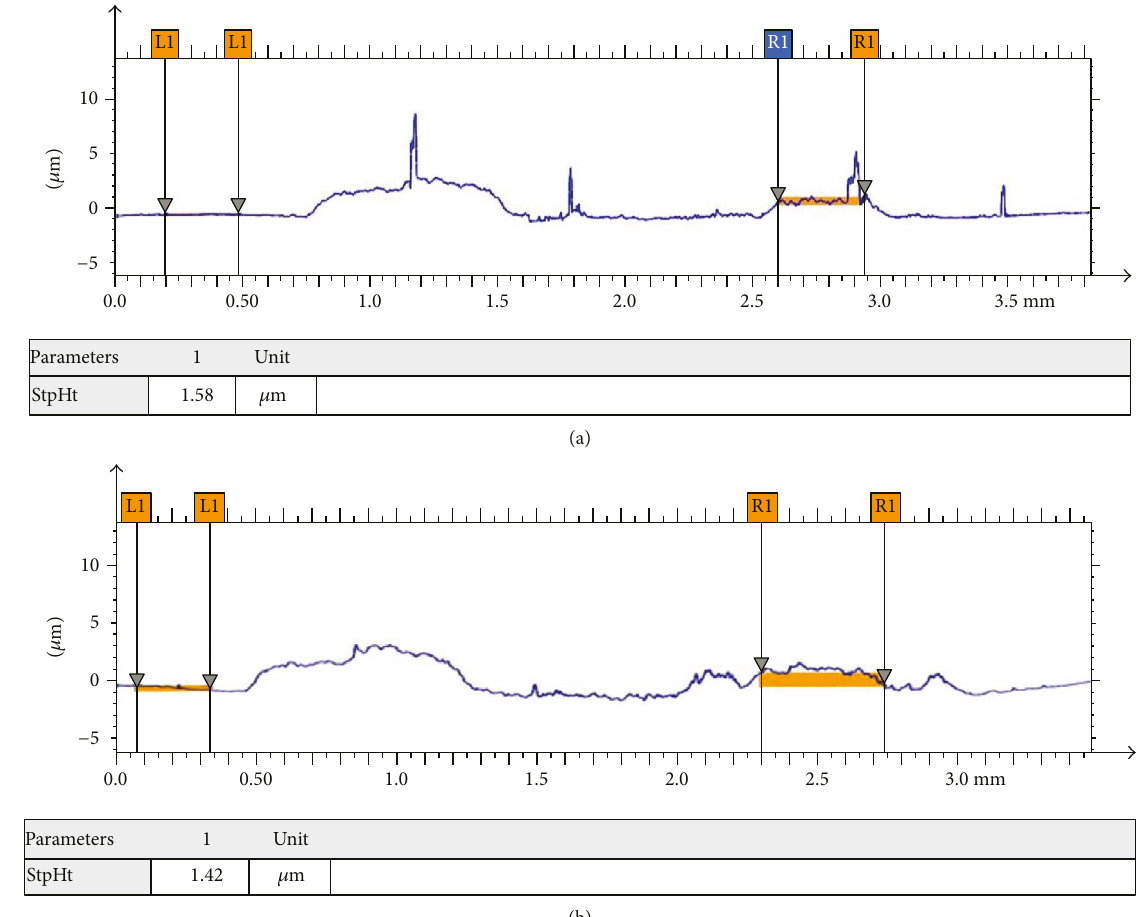
Figure 8: Thickness comparison in anchor region (a) before etching and (b) after etching.